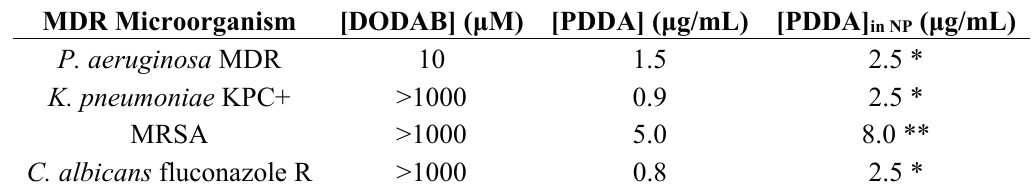
Table 2. MMC values for DODAB alone, PDDA alone or PDDA in NPs against MDR microbial strains. The single asterisk means a DODAB concentration of 2.5 μ M whereas the double asterisk means a DODAB concentration of 8.0 μ M.